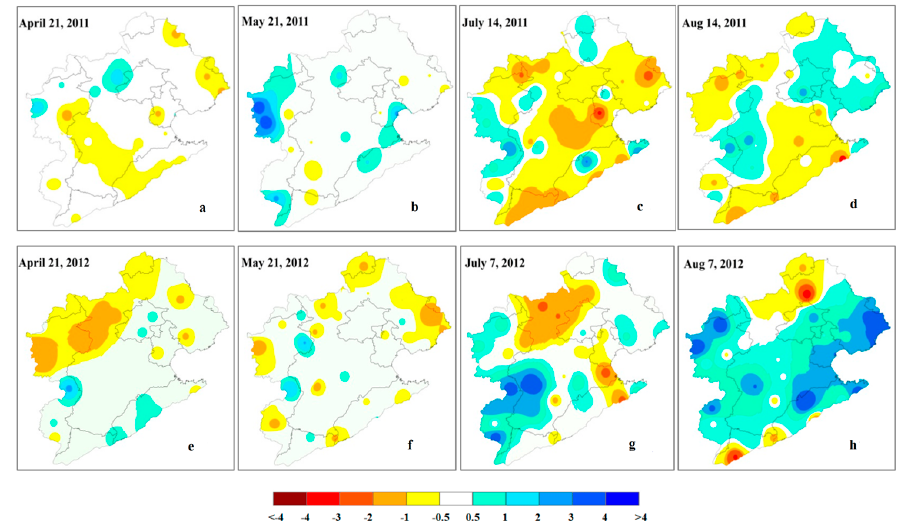
Figure 10. Spatial distribution of dry and wet based on the IrrPDSI in the Haihe River Basin for ( a ) 21 April; ( b ) 21 May; ( c ) 14 July; and ( d ) 14 August 2011; and ( e ) 21 April; ( f ) 21 May; ( g ) 7 July; and ( h ) 7 August